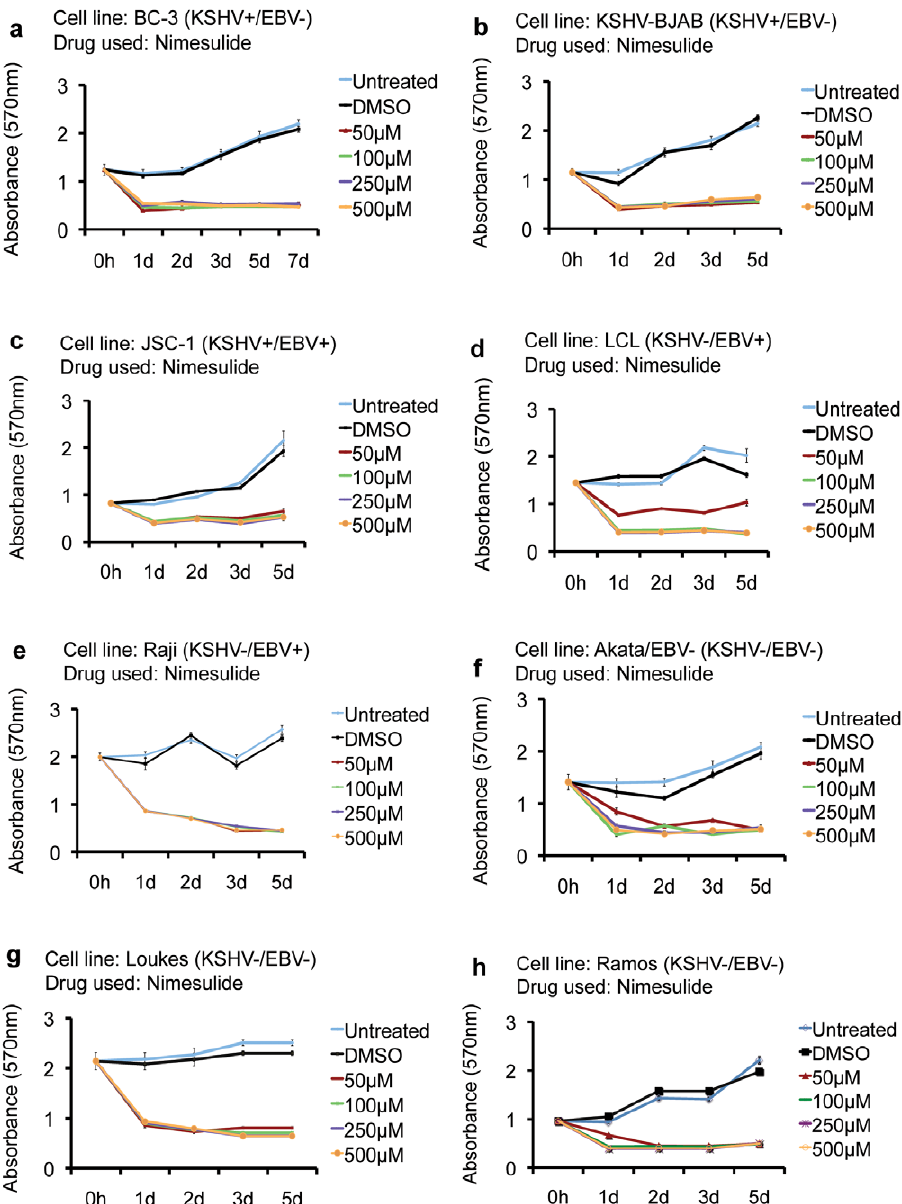
Figure 3. Effect of nimesulide on various NHL cell lines. ( a–h ) 5 6 10 5 BC-3, KSHV-BJAB, JSC-1, LCL, Raji, Akata/EBV-, Loukes and Ramos cells were seeded with the indicated concentrations of nimesulide ( a–h ), DMSO ( a–h ), left untreated ( a–h ). The cell proliferation index was measured by MTT assay at 0 h, day 1 (1d), day 2 (2d), day (3d), and day 5 (5d). The cells were neither replenished with fresh media nor supplemented with the drugs. ( a–h ) One-way ANOVA with Tukey’s posthoc comparison analysis (p , 0.05) was used to determine whether the drug treatment induced a statistically significant difference in the proliferative indexes at 1d, 2d, 3d, and 5d compared to untreated cells of the respective cell lines. Each reaction was done in quadruplicate, and each point represents the average 6 S.D. from three independent experiments.